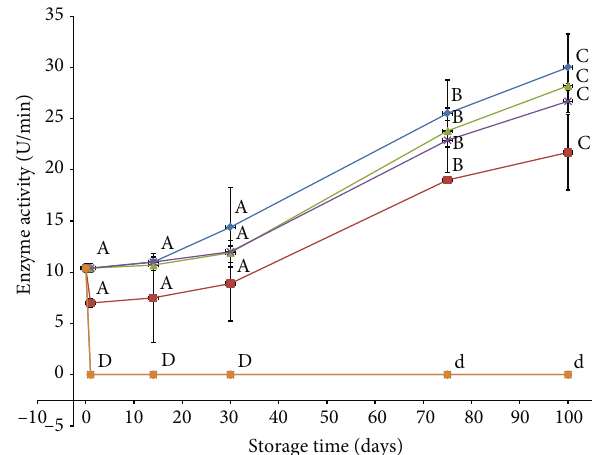
Figure 1: E ff ect of di ff erent preservation methods on polyphenol oxidase activity during storage. Control ( ♦ ), SO ( ▲ ), blanching three minutes ( ■ ), modi fi ed atmosphere packaging ( ╳ ), and blanching ten minutes ( ∗ ). Same letter indicates no statistical di ff erences between